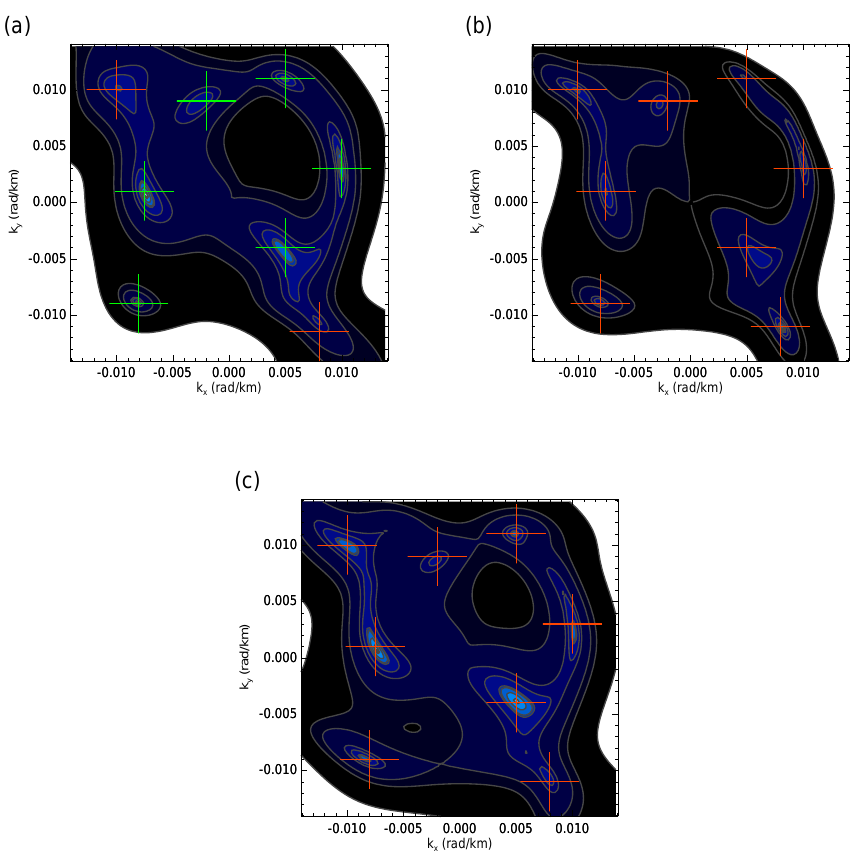
Figure 4. Estimated P(ω, k ) for (a) six random-phase plane waves (green crosses) and two coherent structures (red crosses), (b) eight coherent structures ( λ = 1000, d = 250 in both cases) and (c) eight coherent structures (Gaussian modulated wave packets). The contours denote the same relative powers as in Fig.